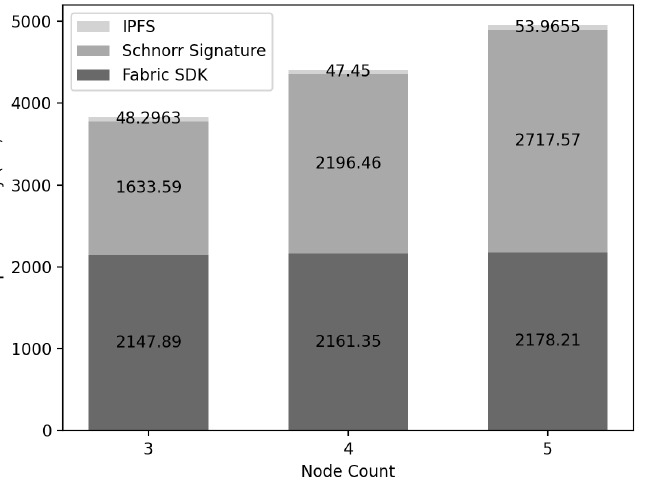
Figure 15. Export latency: the results of measuring the delay time when exporting the IC from Network ic to Network mc